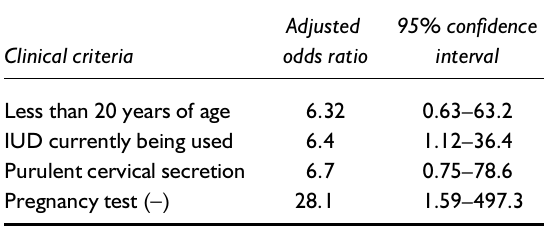
Table 6 PID prediction model for patients having non-specific acute lower abdominal pain in patients attending